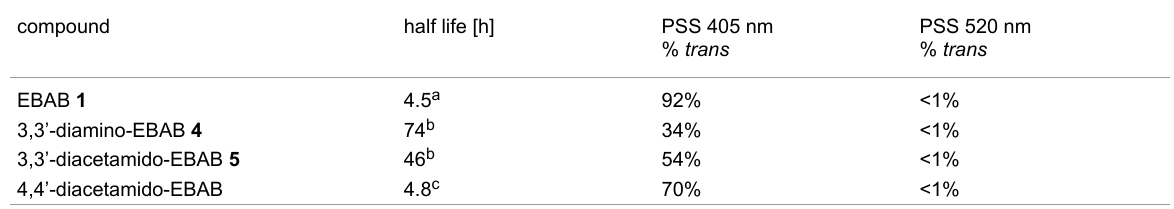
Table 1: Half-life and photostationary states of EBAB 1 and